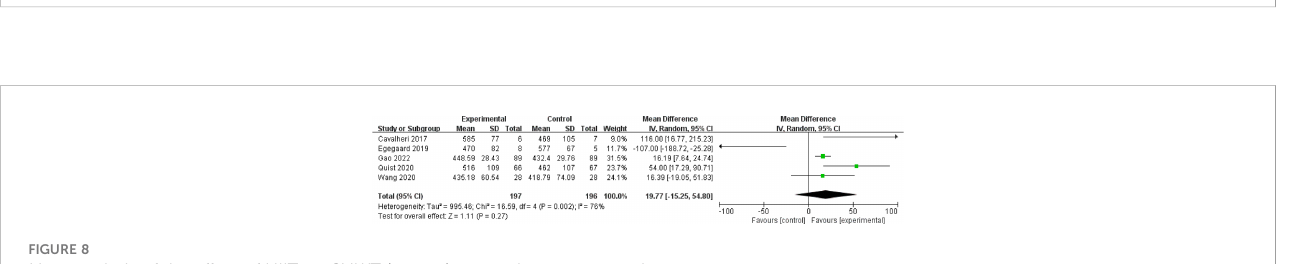
FIGURE 8 Meta-analysis of the effect of HIIT on 6MWT (meters) among lung cancer